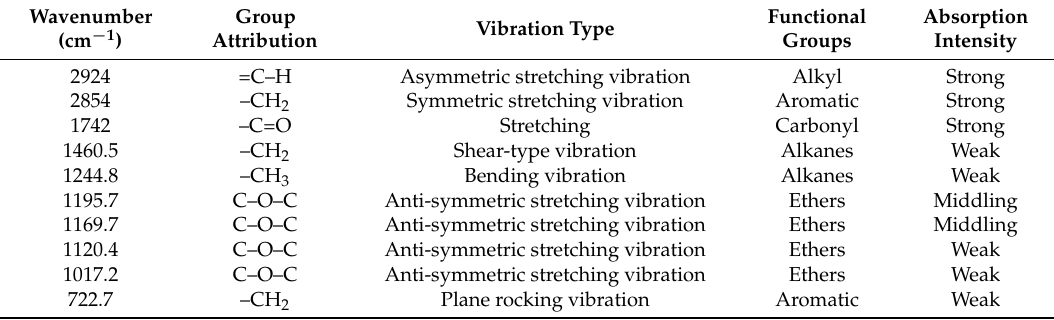
Table 6. Functional groups of SFO biodiesel detected in the FTIR spectrum.